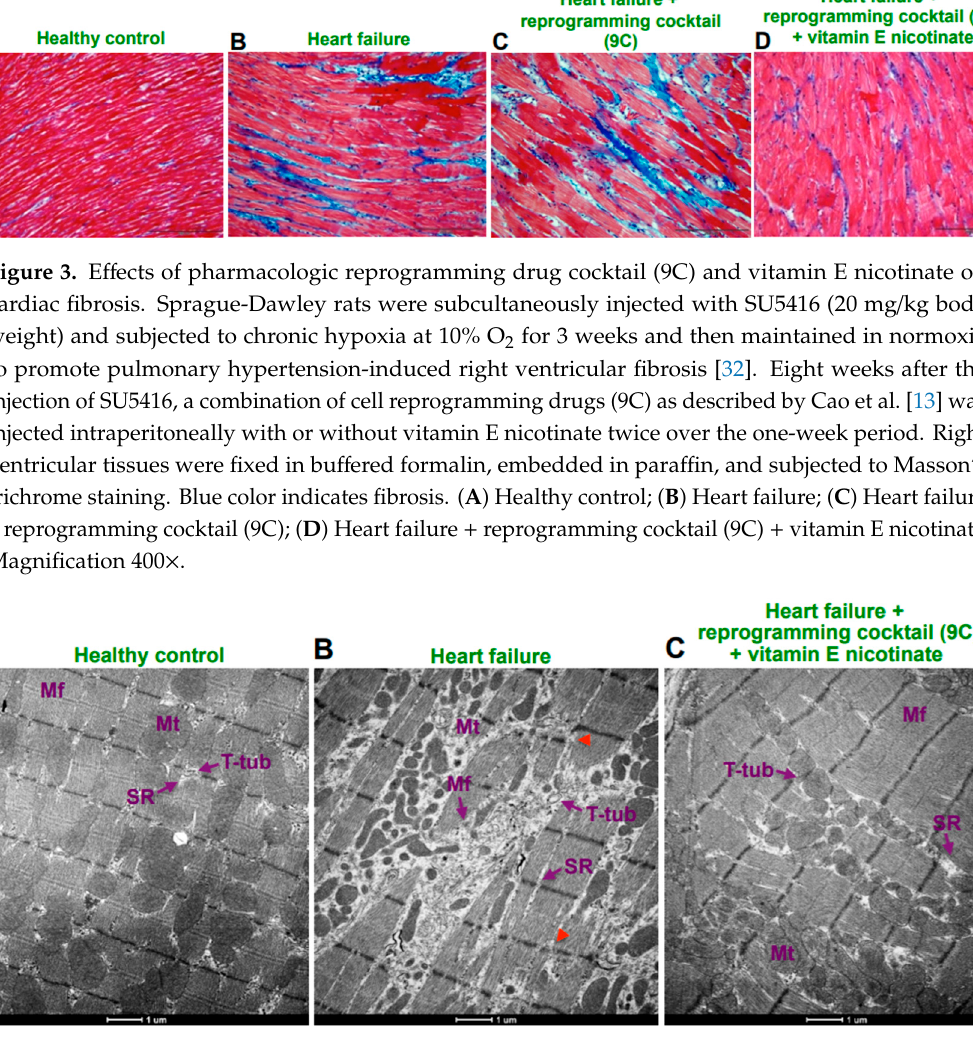
Figure 4. E ff ects of pharmacologic reprogramming drug cocktail (9C) plus vitamin E nicotinate on the cardiac muscle ultrastructure. SU5416-injected Sprague-Dawley rats were subjected to 3 weeks hypoxia and then maintained in normoxia to promote pulmonary hypertension-induced right ventricular damage [32]. Eight weeks after the injection of SU5416, a combination of cell reprogramming drugs (9C) plus vitamin E nicotinate were injected intraperitoneally twice over the one-week period. Tissues were fixed in the 2.5% glutaraldehyde / 0.05 M cacodylate solution, post-fixed with 1% osmium tetroxide and embedded in EmBed812. Ultrathin sections (70 nm) were post-stained with uranyl acetate and lead citrate and examined in the Talos F200X FEG transmission electron microscope (FEI, Hillsboro, OR, USA) [18]. Transmission electron microscopy image represents ( A ) normal ultrastructure of the right ventricular cardiomyocyte of a healthy rat: Mf—myofibrils, Mt—mitochondria, T-tub—tubular system, SR—sarcoplasmic reticulum. ( B ) TEM image of the failing heart due to pulmonary hypertension shows disruptive changes to structural organization of the right ventricular cardiomyocyte, such as damage to the myofilaments (Mf), mismatches of Z-lines with their focal absence (red arrowheads), damage to mitochondria (Mt), alteration to T-tubular system (T-tub) and the sarcoplasmic reticulum (SR). ( C ) TEM image of the